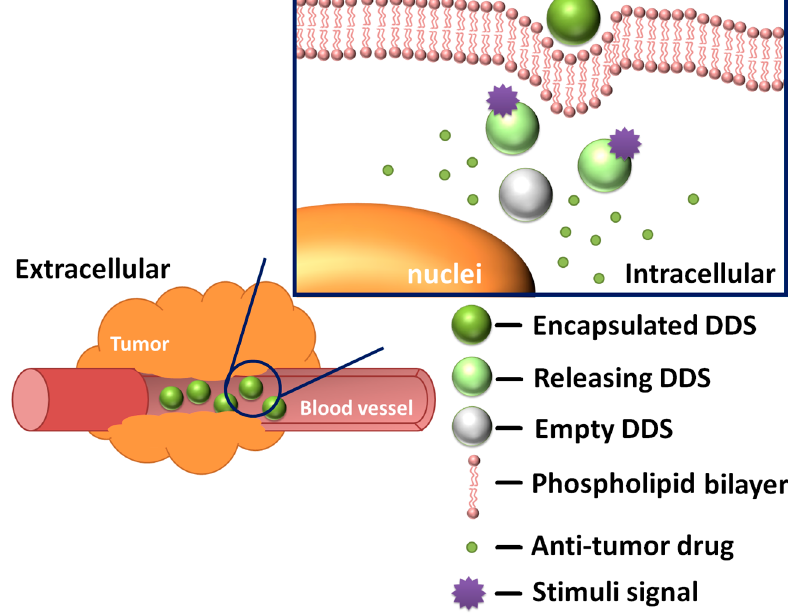
Figure 1. General working mechanism of drug delivery systems (DDSs).